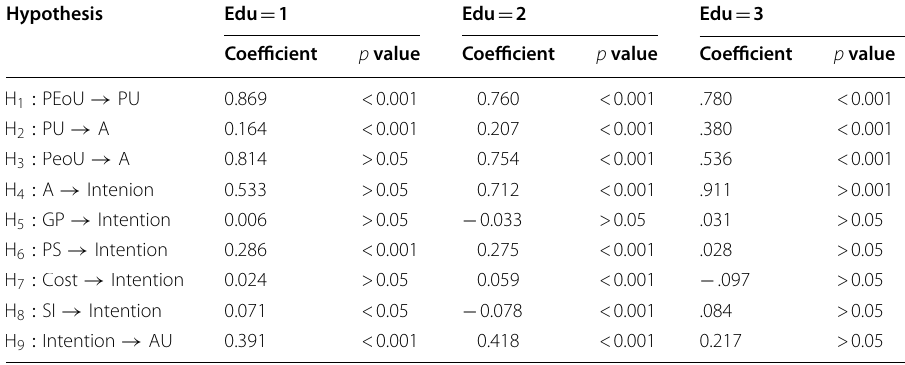
Table 10 The impact of education on e-cash use